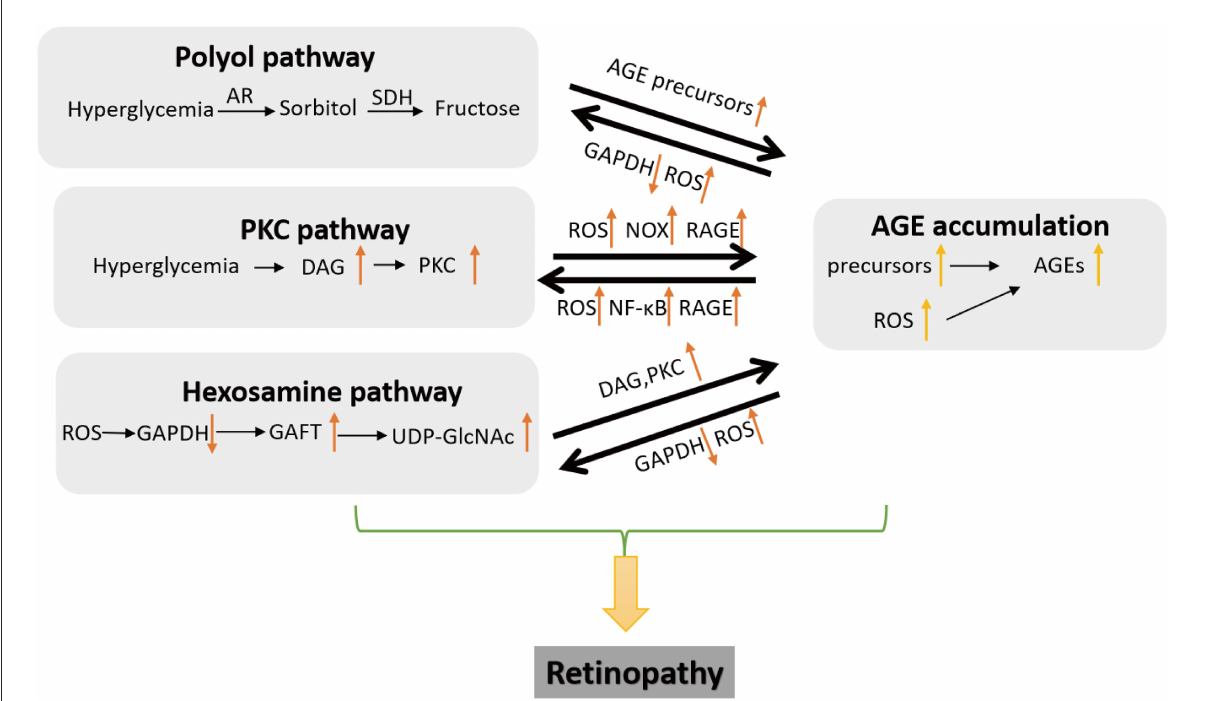
FIGURE3 Metabolic abnormalities in a diabetic complication. Major disorders are polyol pathway, hexosamine biosynthesis pathway, and the activation of protein kinase C (PKC). Polyol pathway promotes the generation of AGE precursors. The activation of PKC induces the expression of vascular endothelial growth factor (VEGF) and RAGE and increase of ROS. Hexosamine pathway causes glycosylation of transcription factors and the generation of diphosphate uracil-N-acetylglucosamine (UDP-GlcNAc). These disorders interact with AGEs to promote the pathogenesis of diabetic retinopathy